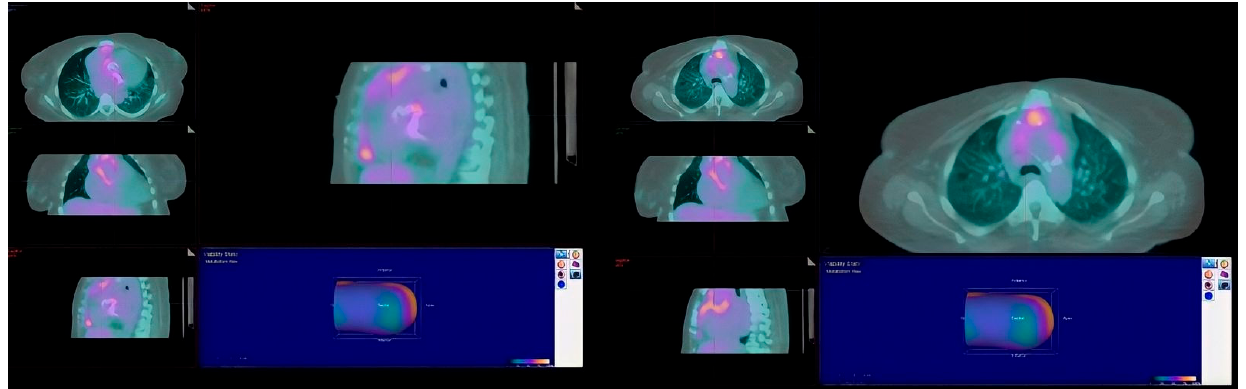
Figure 2. ECG showing atrial fibrillation with a rapid ventricular response.